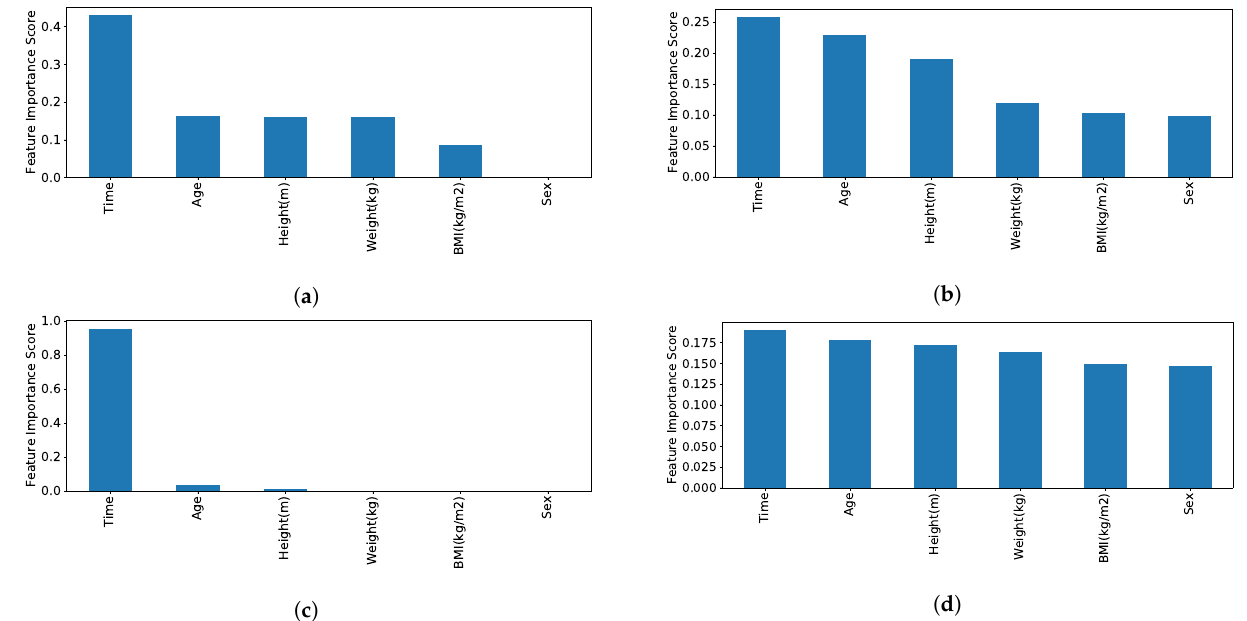
Figure 3. Impurity-based feature importance of the xgboost forests based on mean decrease in impurity as calculated by XGBClassifier.feature_importances_ for ( a ) TUG experiment, ( b ) TUG synthetic, ( c ) FTSTS experiment, and ( d ) FTSTS